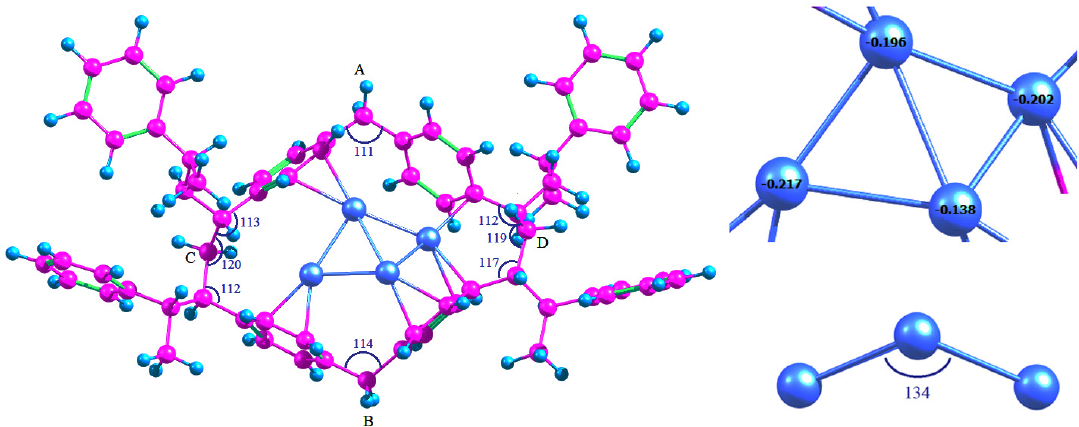
Figure 9. Optimized geometry of Pt 4 incorporated into the HPS micropore and Löwdin charges of Pt atoms. The pore itself was noticeably expanded in the direction of methylene groups “A” and “B” (Table 9): the distance “AB” increased by about 11%. This also caused the decrease of tension of the methylene groups “A” and “B” since their valence angles decreased from 115 ◦ and 118 ◦ to 111 ◦ and 114 ◦ , respectively. At the same time, some tension appeared in the methine radical located on the segment “BD” between the BZ ring and the methylene group “D”. Table 9. Structure parameters of the polymer micropore in case of Pt 4 incorporation. Distance,